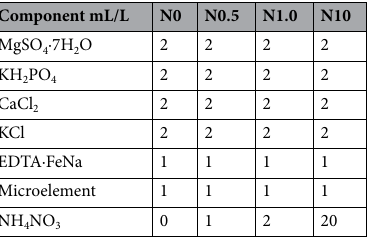
Table 2. Nutrient element components in different treatments. *After mixing the ingredients; volume in 1 L of sterile